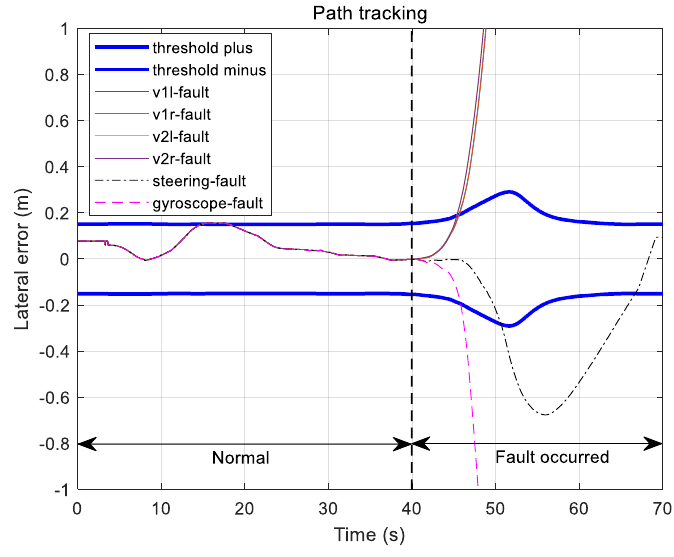
Figure 16. Path tracking errors for each sensor fault.